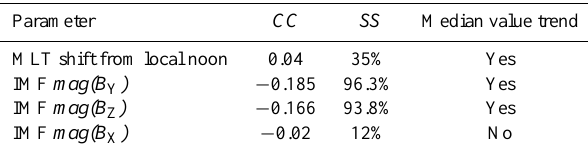
Table 2. Correlation coefficients, statistical significances and the presence of obvious trends in the median values between electron edge size and MLT shift from the local noon, and between electron edge size and absolute values of the IMF